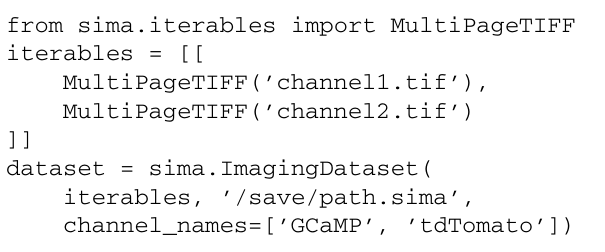
different regions imaged by different frames due to motion. The light gray region indicates the maximum frame-size that can be selected for the motion correction output, such that all pixels locations that were ever imaged are within the frame. The dark gray region indicates the default and minimum frame-size that can be selected for the motion correction output, such that all pixels locations within the frame are within the field of view at all